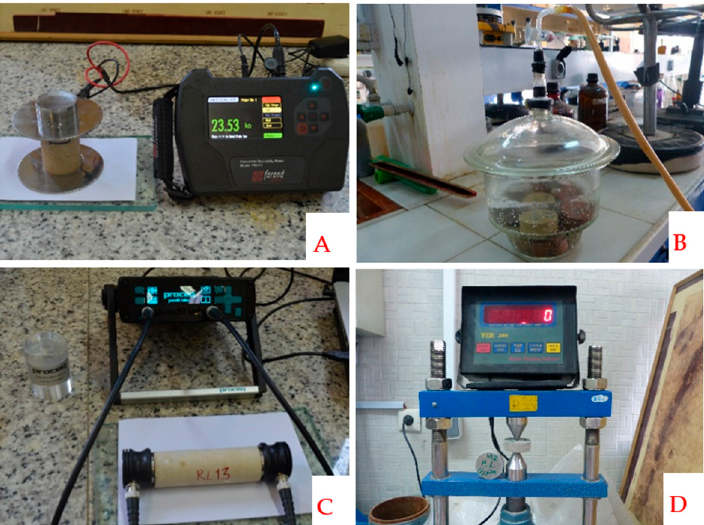
Figure 3. Simple test methods: electrical resistivity ( A ), vacuum saturation ( B ), ultrasonic wave velocity ( C ), and point load index ( D